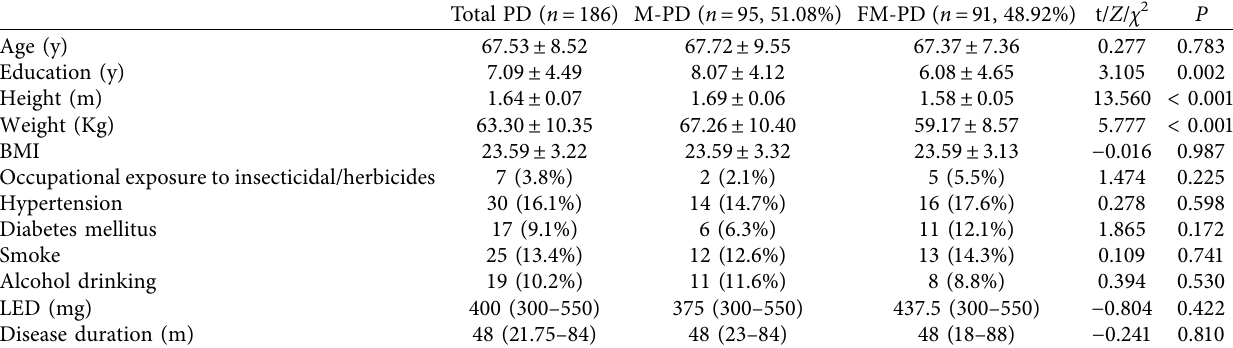
Table 1: General information of male and female PD patients.